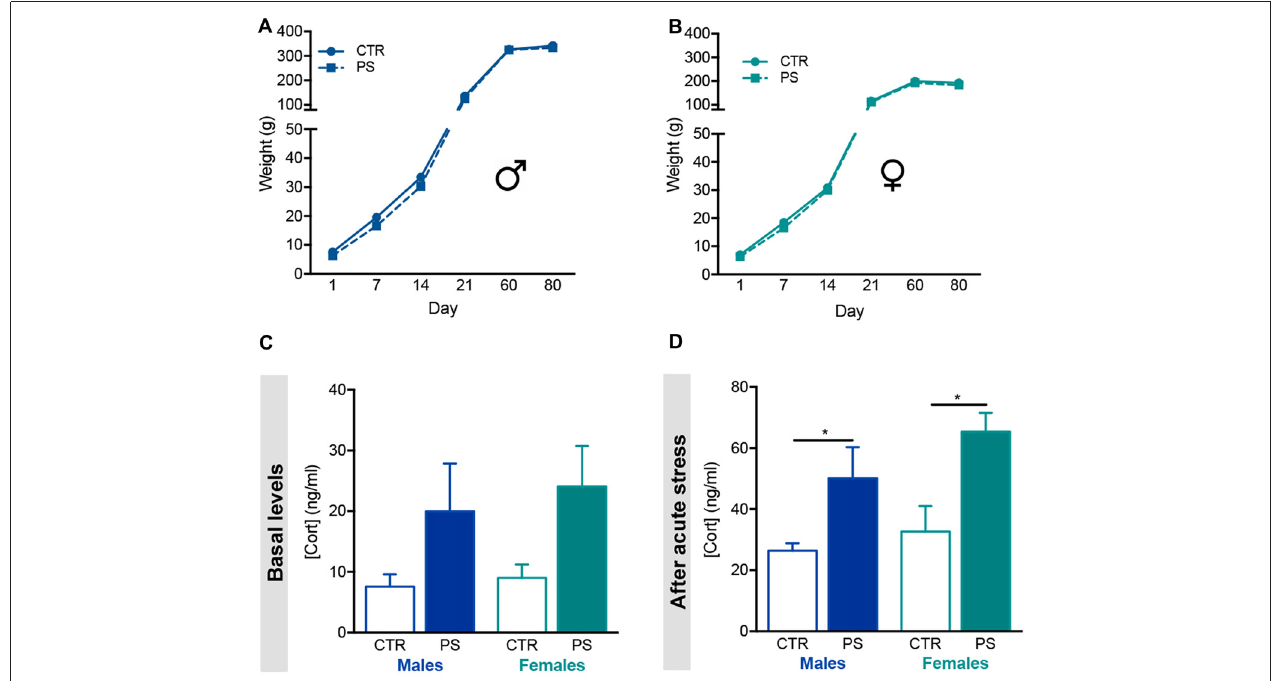
FIGURE 2 | Prenatal mild stress disrupts corticosterone levels in offspring. (A) Body weight gain of male rats prenatally exposed to stress (PS, n = 28) and control group (CTR, n = 8), showing no differences in body weight gain as animals aged. (B) Body weight gain of female rats prenatally exposed to stress (PS, n = 20) and control group (CTR, n = 9), showing no differences between groups. (C) Basal serum corticosterone levels of male and female PS is increased in comparison with CTR rats, although not statistically significant (n PS males = 6, n CTR males = 6, n PS females = 6, n CTR females = 4). (D) Upon acute stress exposure (restraint for 30 min), male and female PS rats presented significantly increased serum levels of corticosterone (n PS males = 8, n CTR males = 4, n PS females = 6, n CTR females = 6). Error bars denote SEM. ∗ p <